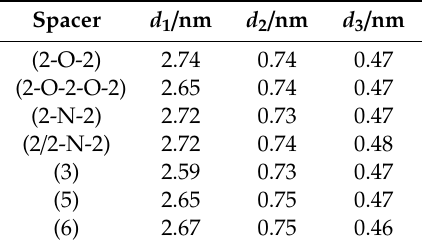
Figure 4. WAXS profiles of 2C 12 (Spacer) NTf 2 at 25 °C: (2-O-2) (orange ● ), (2-O-2-O-2) (yellow green ● ), (2-N-2) (sky blue ● ), (2/2-N-2) (30 °C, blue ● ), (3) (purple ● ), (5) (pink ● ), and (6) (red ● ). Table 1. d 1 , d 2 , and d 3 values obtained from the WAXS profiles of amphiphilic gemini ionic liquids 2C 12 (Spacer) NTf 2